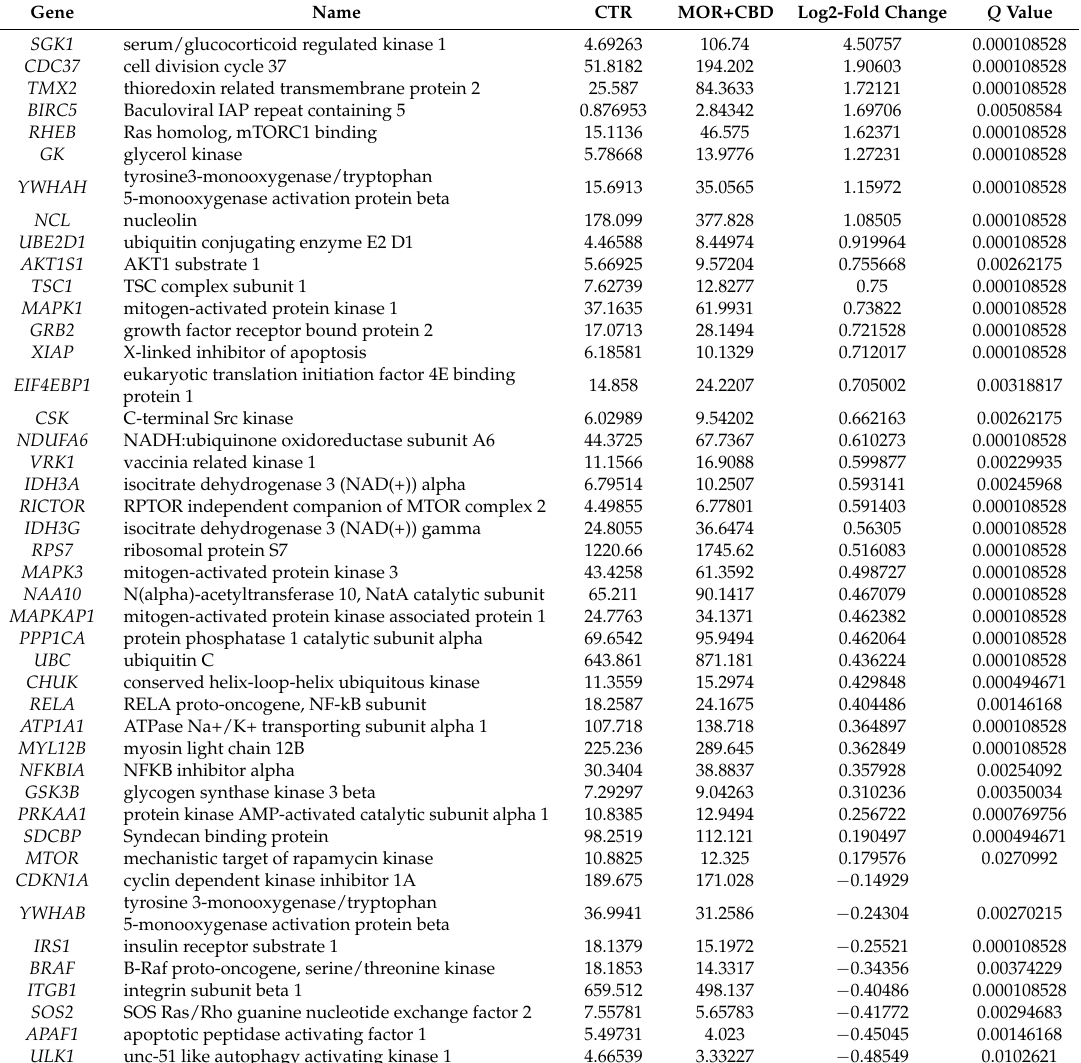
Table 5. Up- and downregulated genes, involved in “mTOR